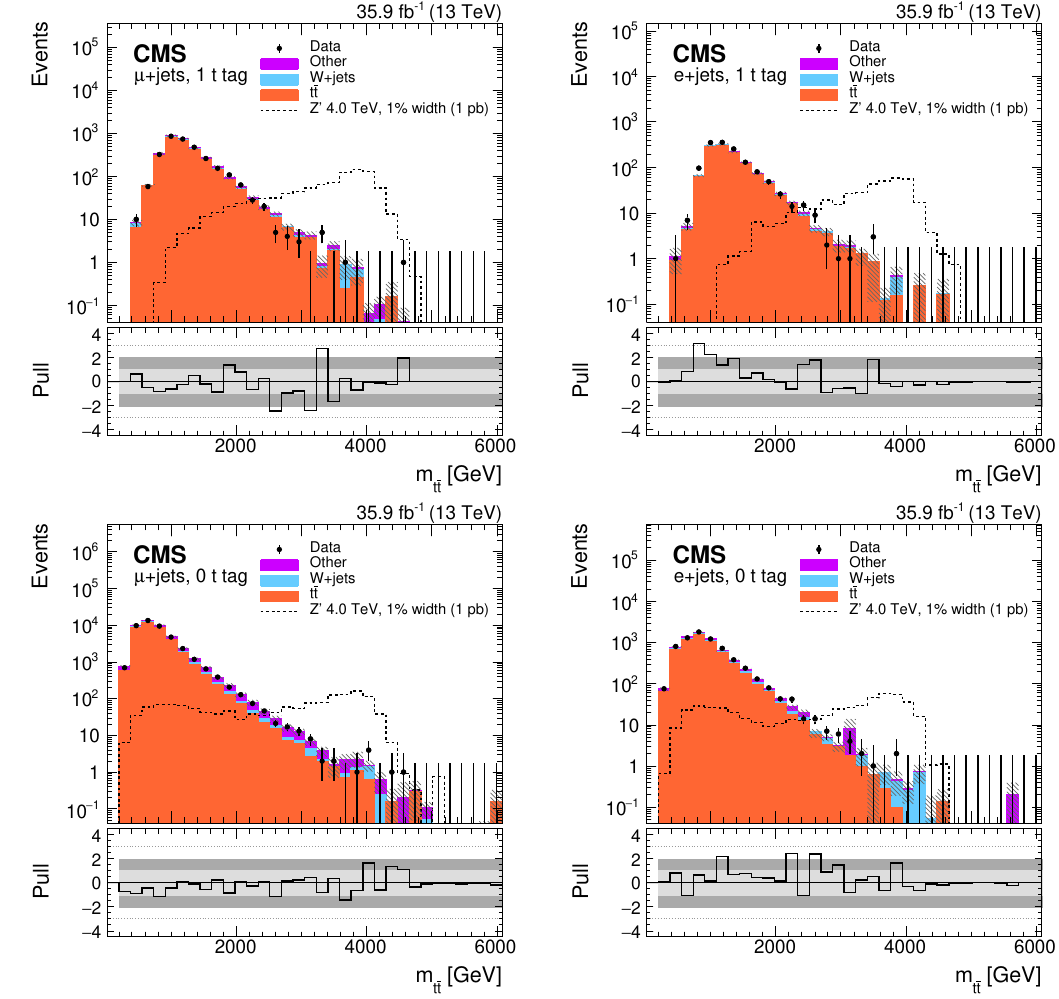
Figure 9 . Distributions of m for the single-lepton channel SRs for the muon (left) and electron tt (right) categories with (upper) and without (lower) t tagging. The contribution expected from a 4 TeV Z 0 boson, with a relative width of 1%, is shown normalized to a cross section of 1 pb. The hatched band on the simulation represents the uncertainty in the background prediction. The lower panel in each plot shows the pull of each histogram bin from the SM prediction. The light (dark) gray band represents a pull of one (two) s.d. from the predicted